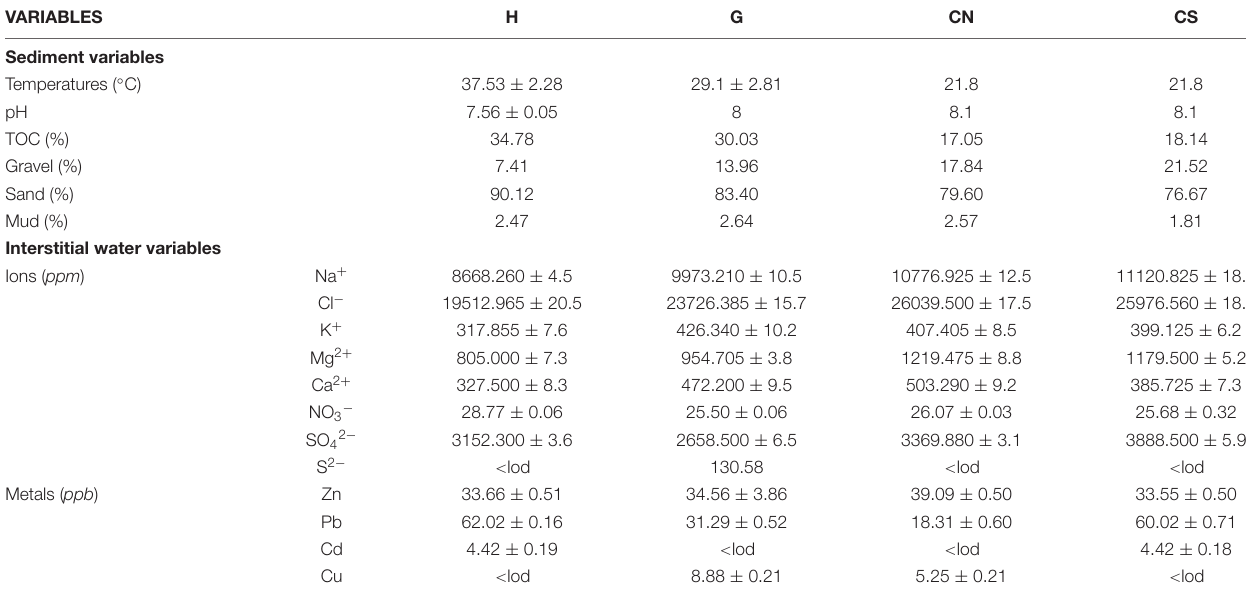
TABLE 1 | Environmental condition of the study area. Data were expressed as percentages or averaged ( ± S.D.) among three replicates at each site (H; G; CN; CS). VARIABLES Sediment